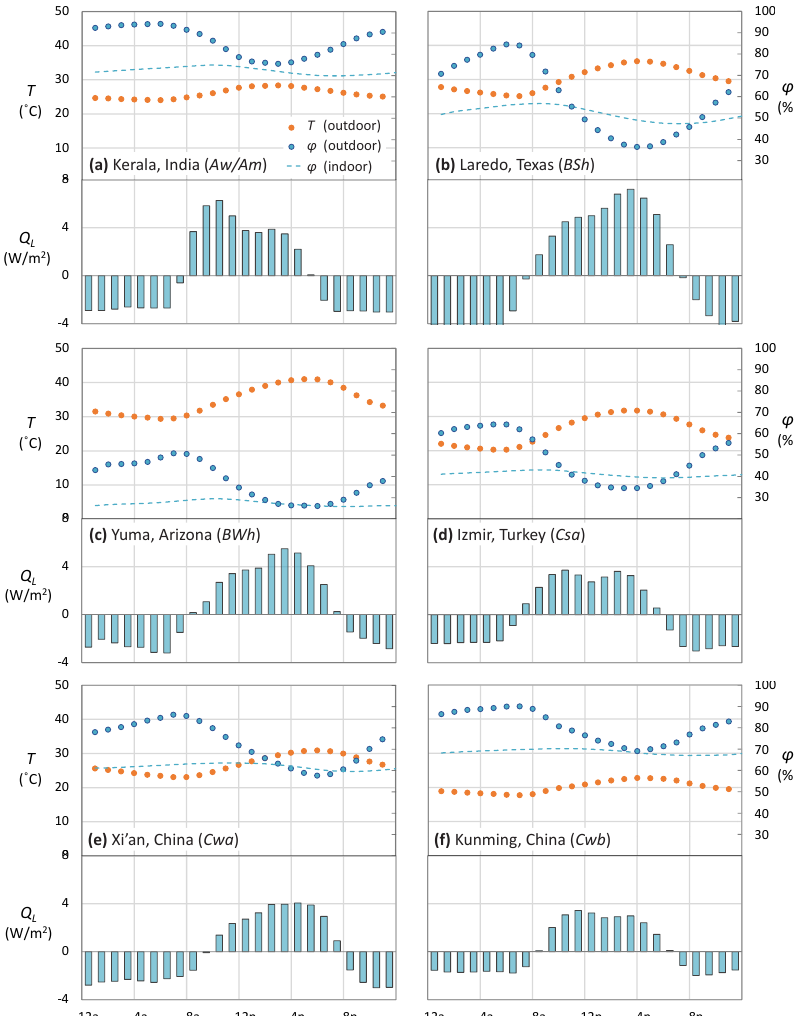
Figure 8. Variation of latent heat flux ( Q L ; lower panels) and indoor relative humidity ( φ ; upper panels) with climate in adobe walls. Dots show average hourly July values of outdoor air temperature T (orange) and relative humidity φ (blue) in each climate (Table 3; ( a ) Kerela, India; ( b ) Laredo, Texas; ( c ) Yuma, Arizona; ( d ) Izmir, Turkey; ( e ) Xi’an, China; ( f ) Kunming, China), dashed lines show indoor relative humidity, and bars show hourly values of Q L averaged among all orientations (N, S, E, W) in simulations of 20cm-thick walls of a well-characterized Chinese adobe ([26,77]; Section 3.2.1). Ambient humidity was the only source of